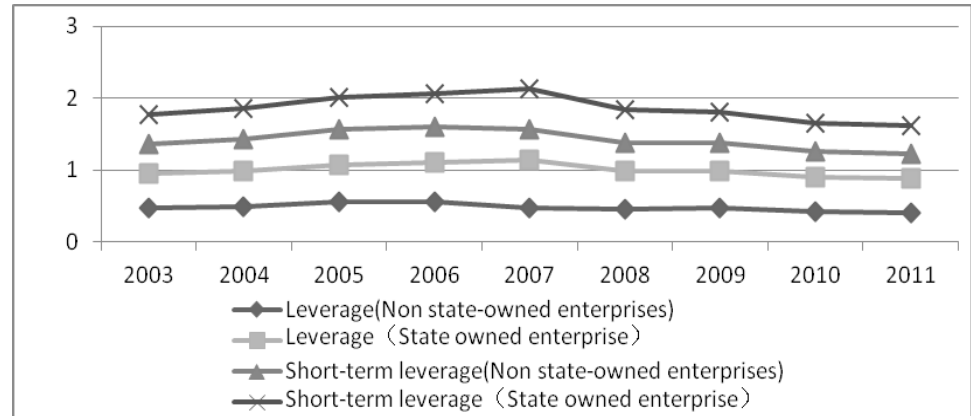
Figure 3. The tendency of the Asset-liability ratio and short-term debt ratio of the state-owned enterprises and non-state-owned enterprises over the period 2003-2011